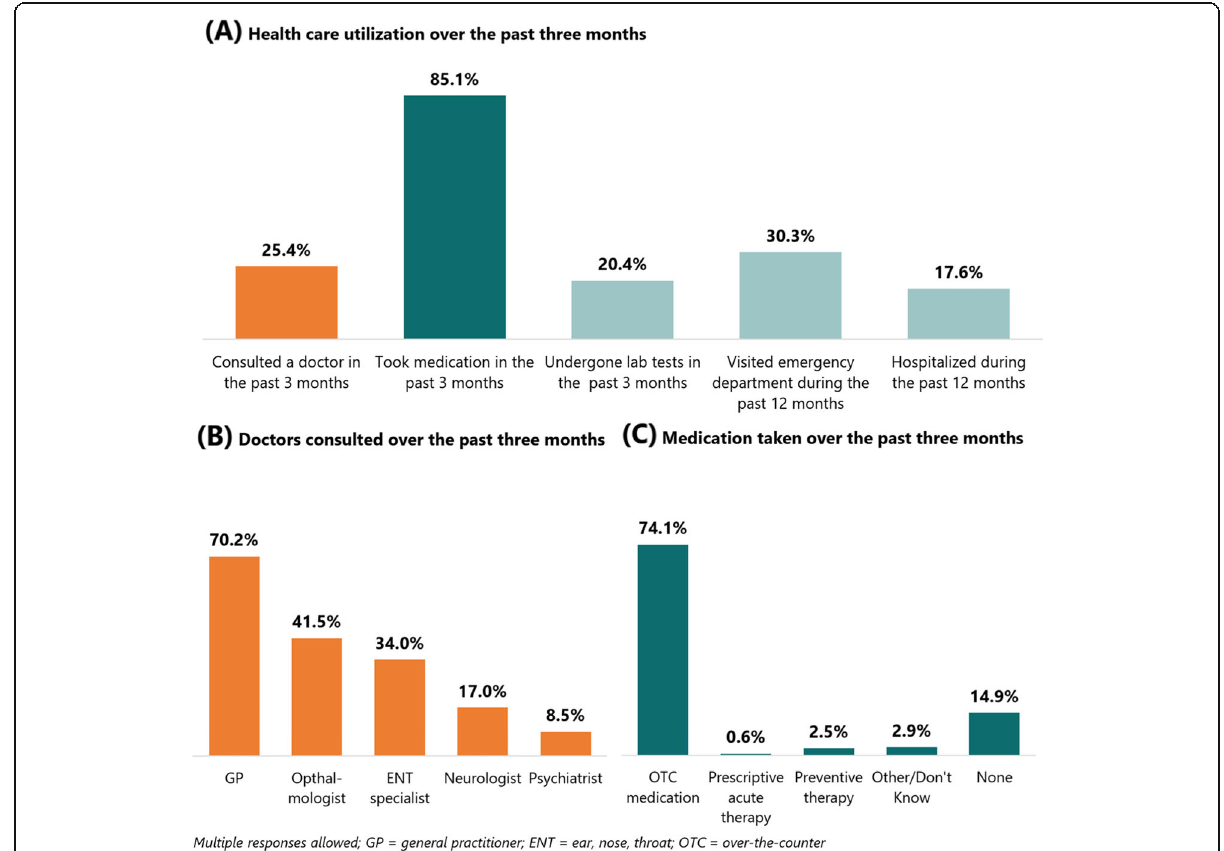
Fig. 4 Health care utilization for migraine-related